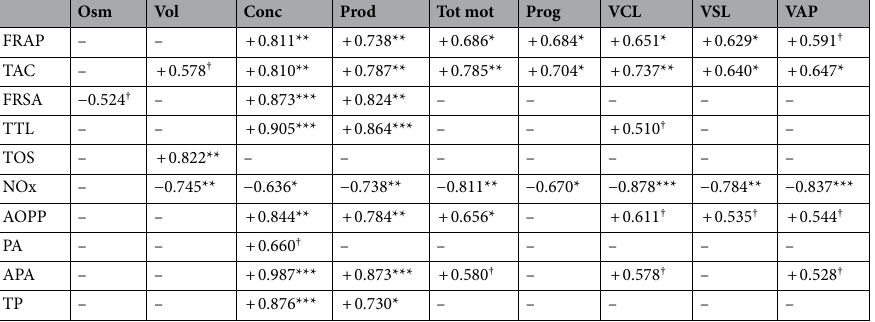
normo-spermic men, Gulum and colleagues 30 found higher levels of oxidative parameters and lower levels of antioxidant parameters in the azoospermic group. In the present paper, the SP antioxidant status was assessed by different methods whose analytical results are the expression of the cumulative actions of all the antioxidants pre-